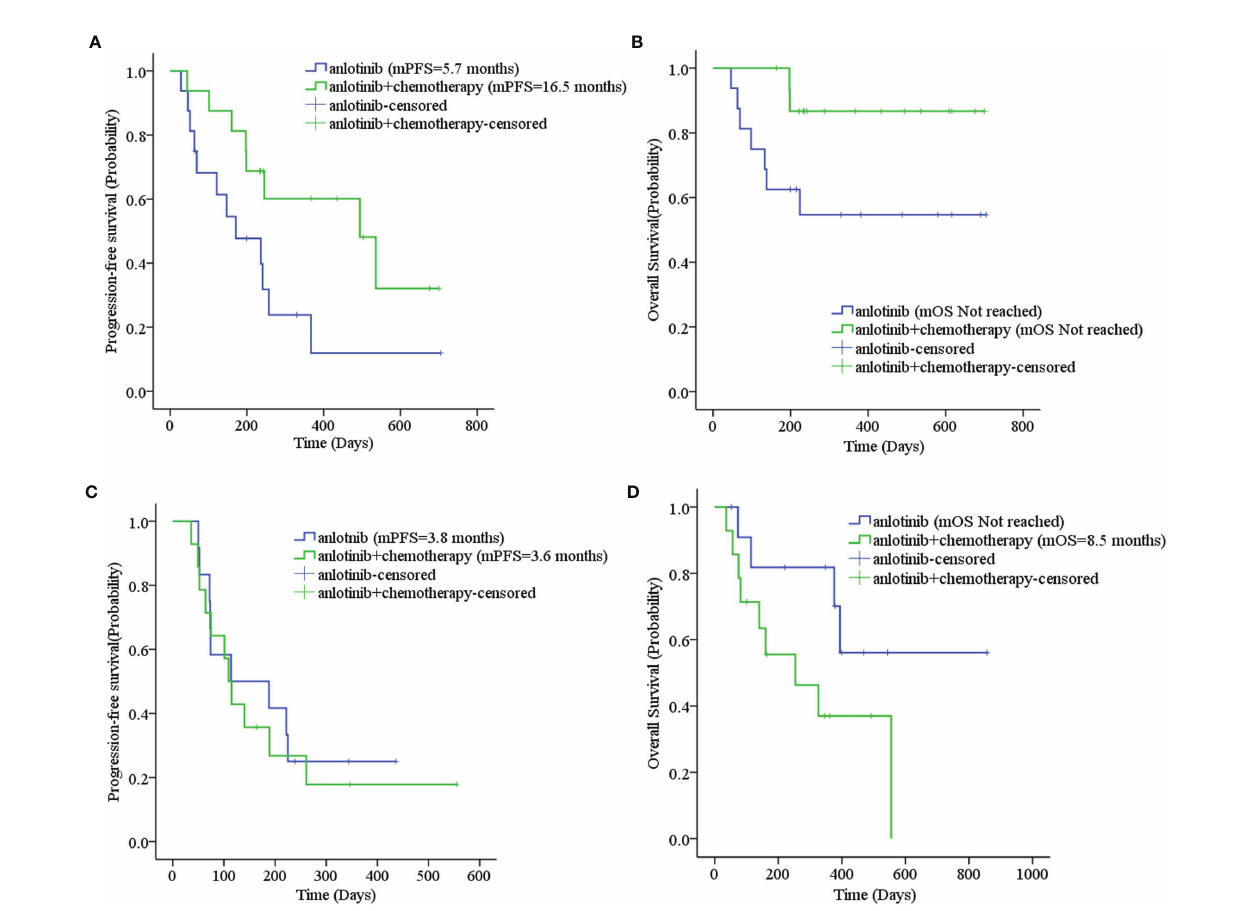
FIGURE 3 | (A) Progression-free survival strati fi ed by treatment regimen in second-line therapy; (B) Overall survival strati fi ed by treatment regimen in second-line therapy; (C) Progression-free survival strati fi ed by treatment regimen in third- and further-line therapy; (D) Overall survival strati fi ed by treatment regimen in third- and further-line